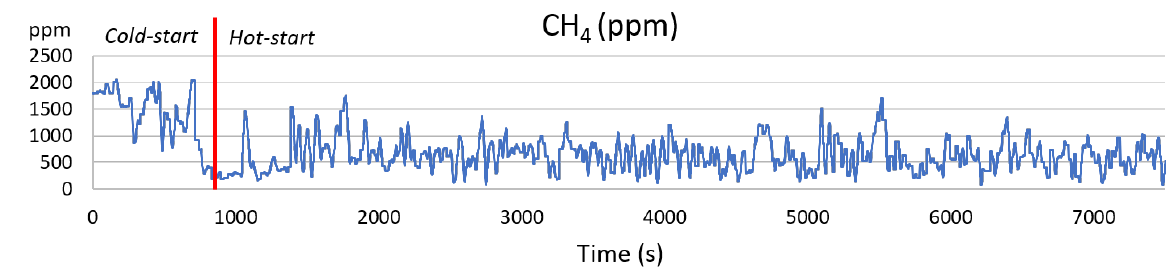
Figure 8. CH 4 emissions during combined cold- and hot-start test.